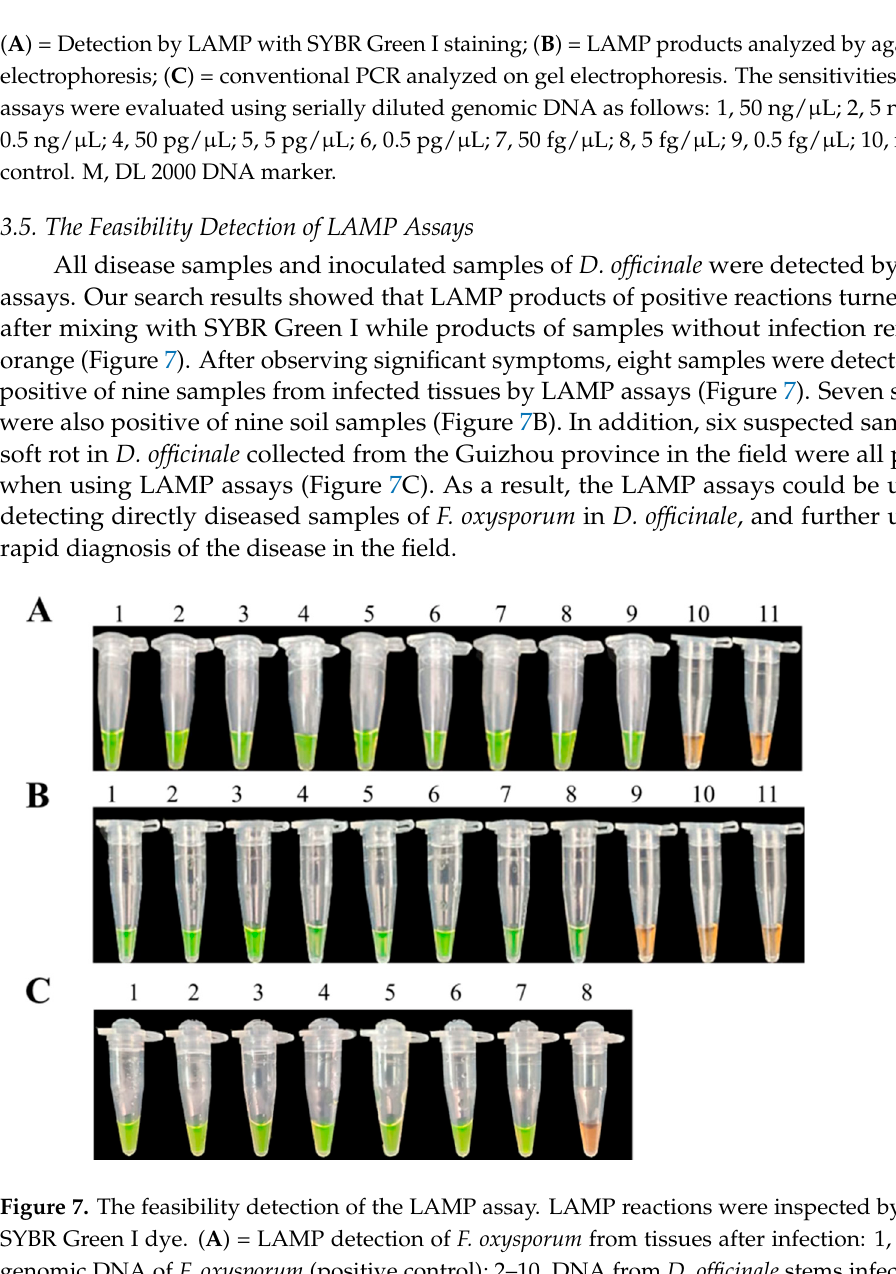
( A ) = Detection by LAMP with SYBR Green I staining; ( B ) = LAMP products analyzed by agarose gel electrophoresis; ( C ) = conventional PCR analyzed on gel electrophoresis. The sensitivities of these assays were evaluated using serially diluted genomic DNA as follows: 1, 50 ng/ µ L; 2, 5 ng/ µ L; 3,